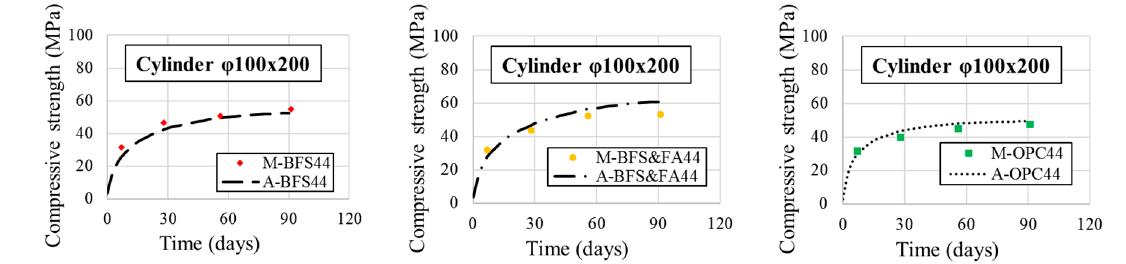
Figure 9. Compressive strength of concrete (M-Measured and A-Analytical). Table 2. Trial mixture designs of potential concrete to be used for Shinkesen Bridge deck.